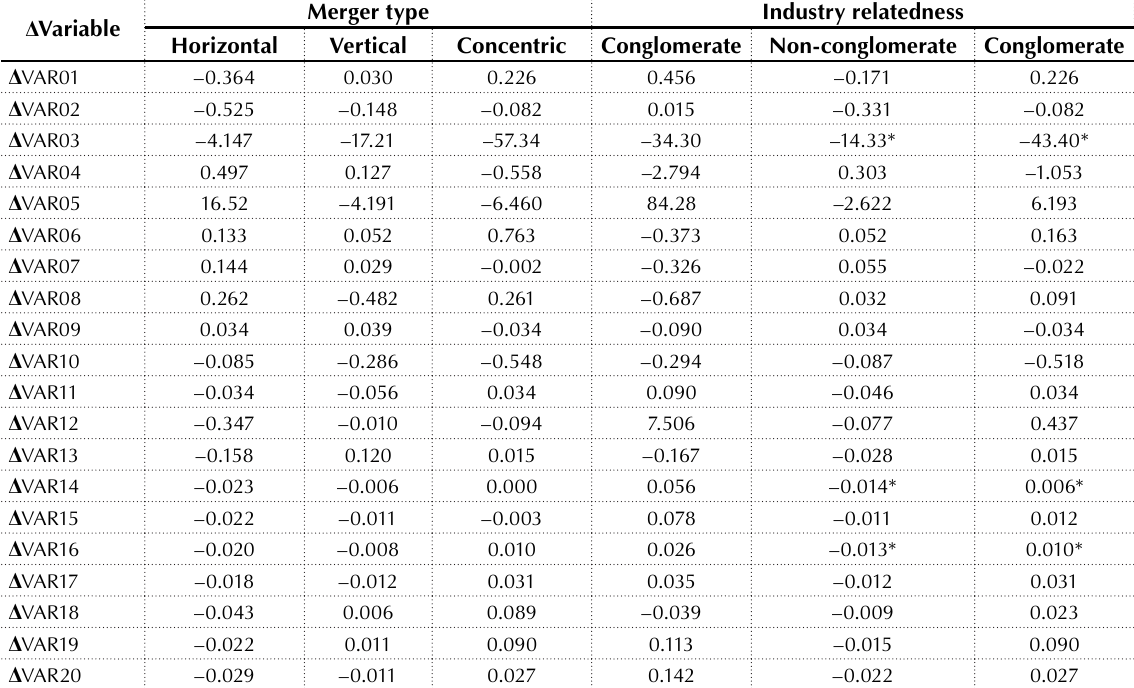
Table 5. Results (Kruskal-Wallis test) from the merger type and the industry relatedness ( H2 - H3 ) Δ